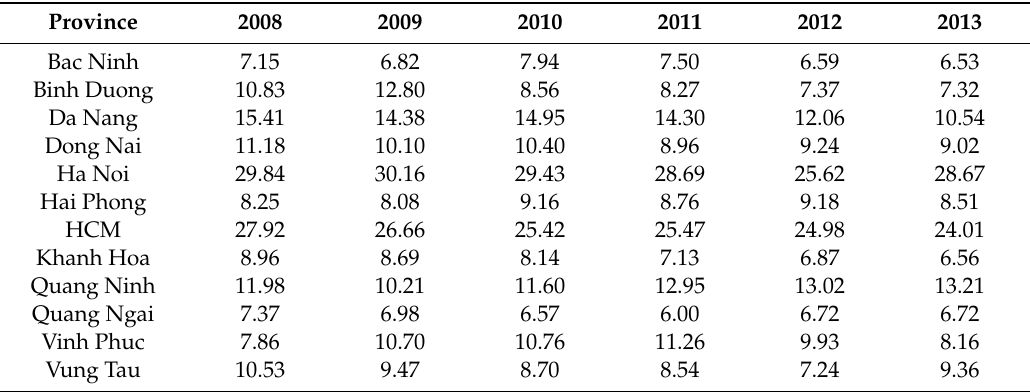
Table 3. The value of fiscal decentralisation index for 13 provinces in 2008–2013